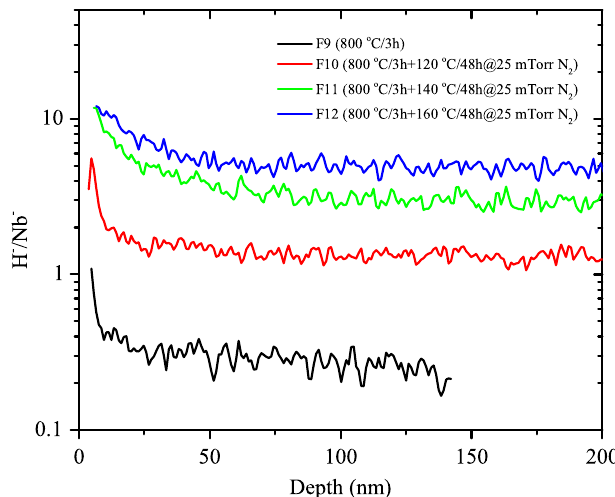
FIG. 8. H − = Nb − as a function of depth measured by TOF- SIMS in Nb samples F9 – F12.